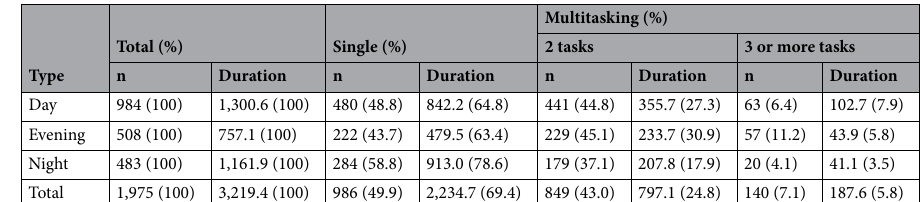
(Table 3). The top five nursing activities in terms of time spent in a day were as follows: 23.7% (347.4 min) on scheduled